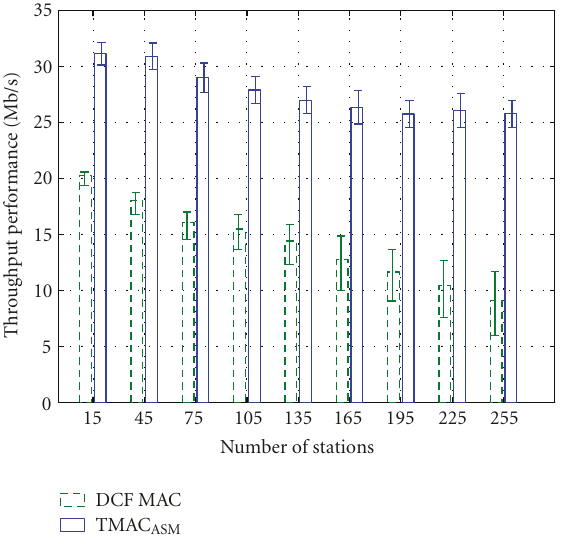
Figure 8: Network throughput versus the number of